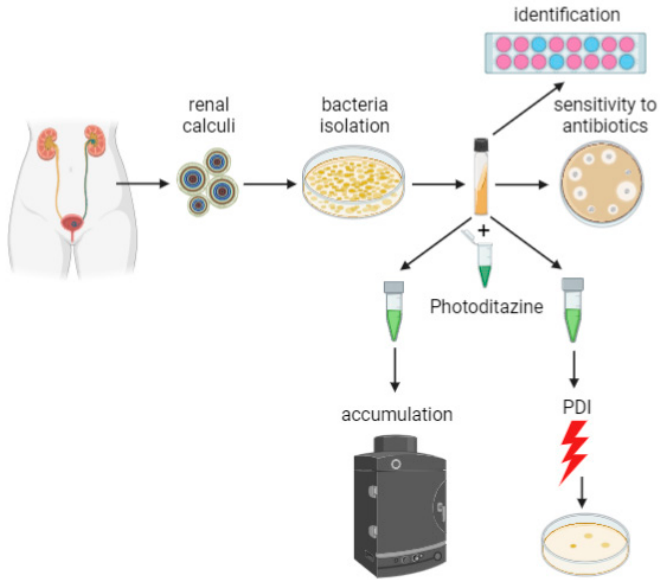
Figure 1. The study design.